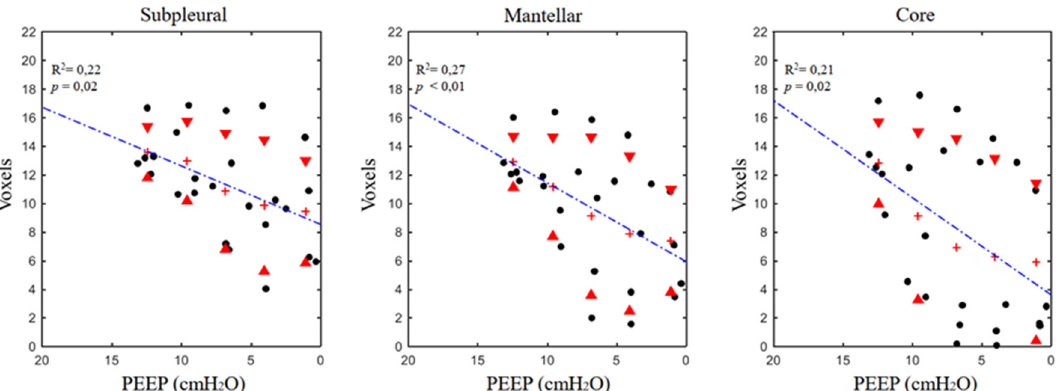
Figure 2. Positive end-expiratory pressure versus regional airspace numerosity (ASnum, (airpaces/mm 3 )) in the different analyzed regions of interest (ROIs). See the text for a detailed description of the computation. Red triangles mark standard deviations; crosses express the mean value at the corresponding positive end-expiratory pressure (PEEP).